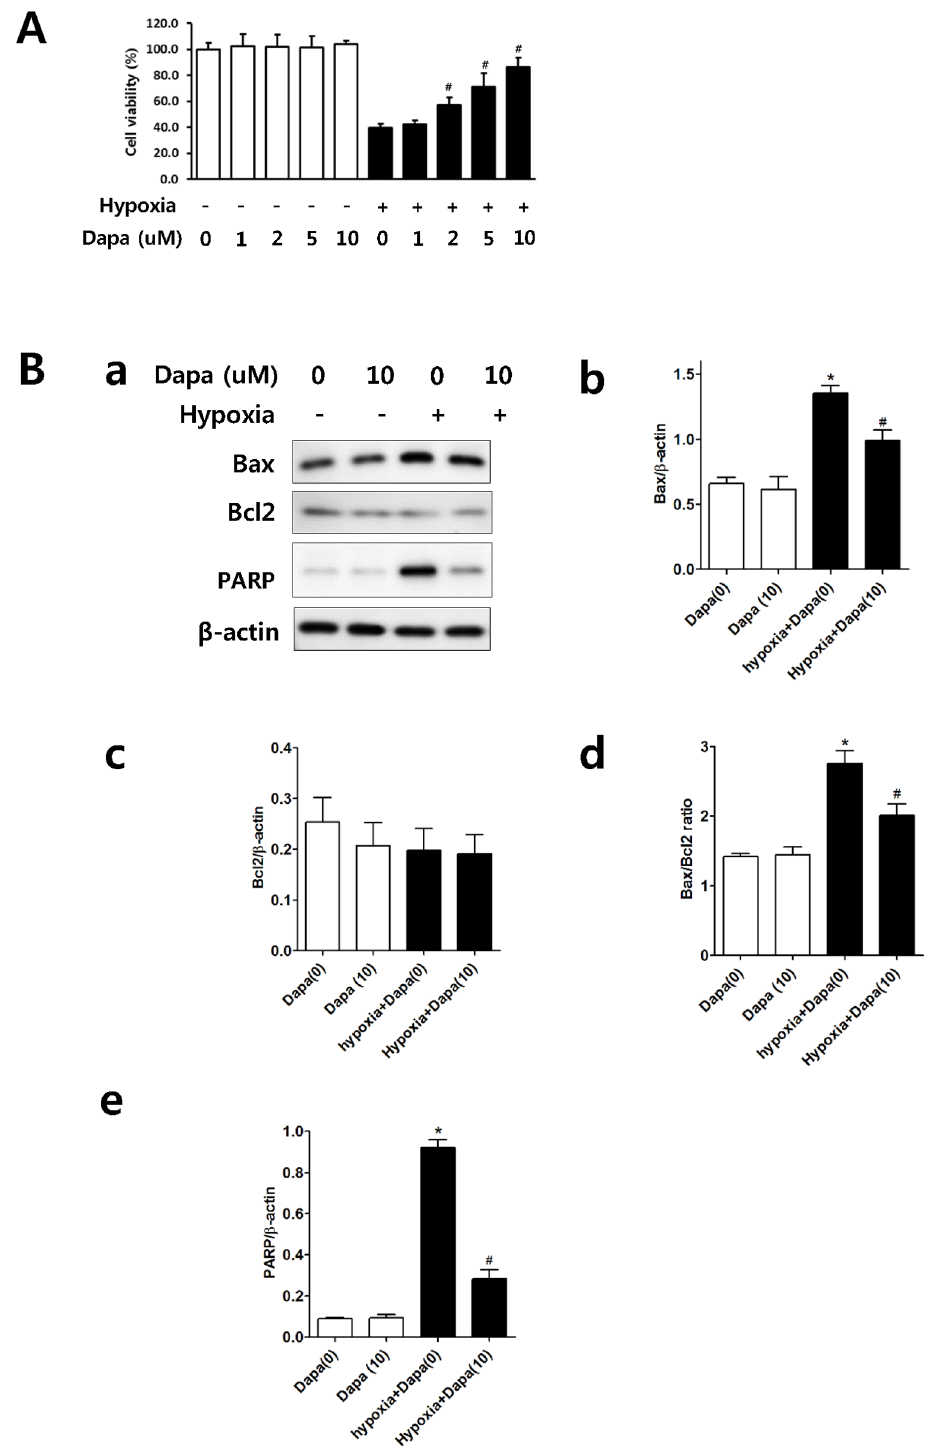
Fig 3. Effects of dapagliflozin on HK2 cell survival and apoptosis. (A) Dapagliflozin significantly increased the cell survival in hypoxic HK2 cell in a dose-dependent manner. (B) Representative western blot (B-a). Dapagliflozin significantly decreased the Bax expression and Bax/Bcl2 ratio in hypoxic HK2 cells (B-b and d). However, Bcl2 expression was unaffected by dapagliflozin in hypoxic HK2 cells (B-c). Dapagliflozin significantly decreased the PARP expression in hypoxic HK2 cells (B-e) * P < 0.05 vs. normoxic HK2 cells,